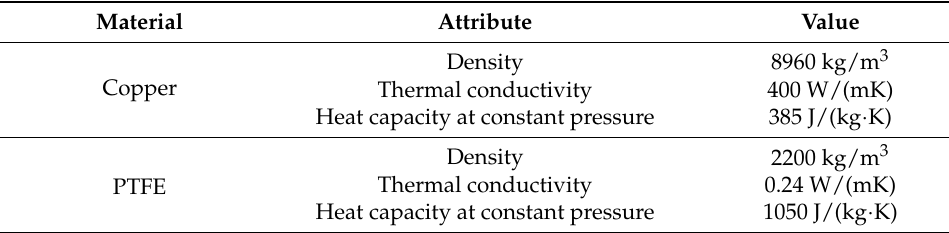
Figure 1. Schemes of the tested sample with the flaw in the numerical model. Table 1. Cable model material